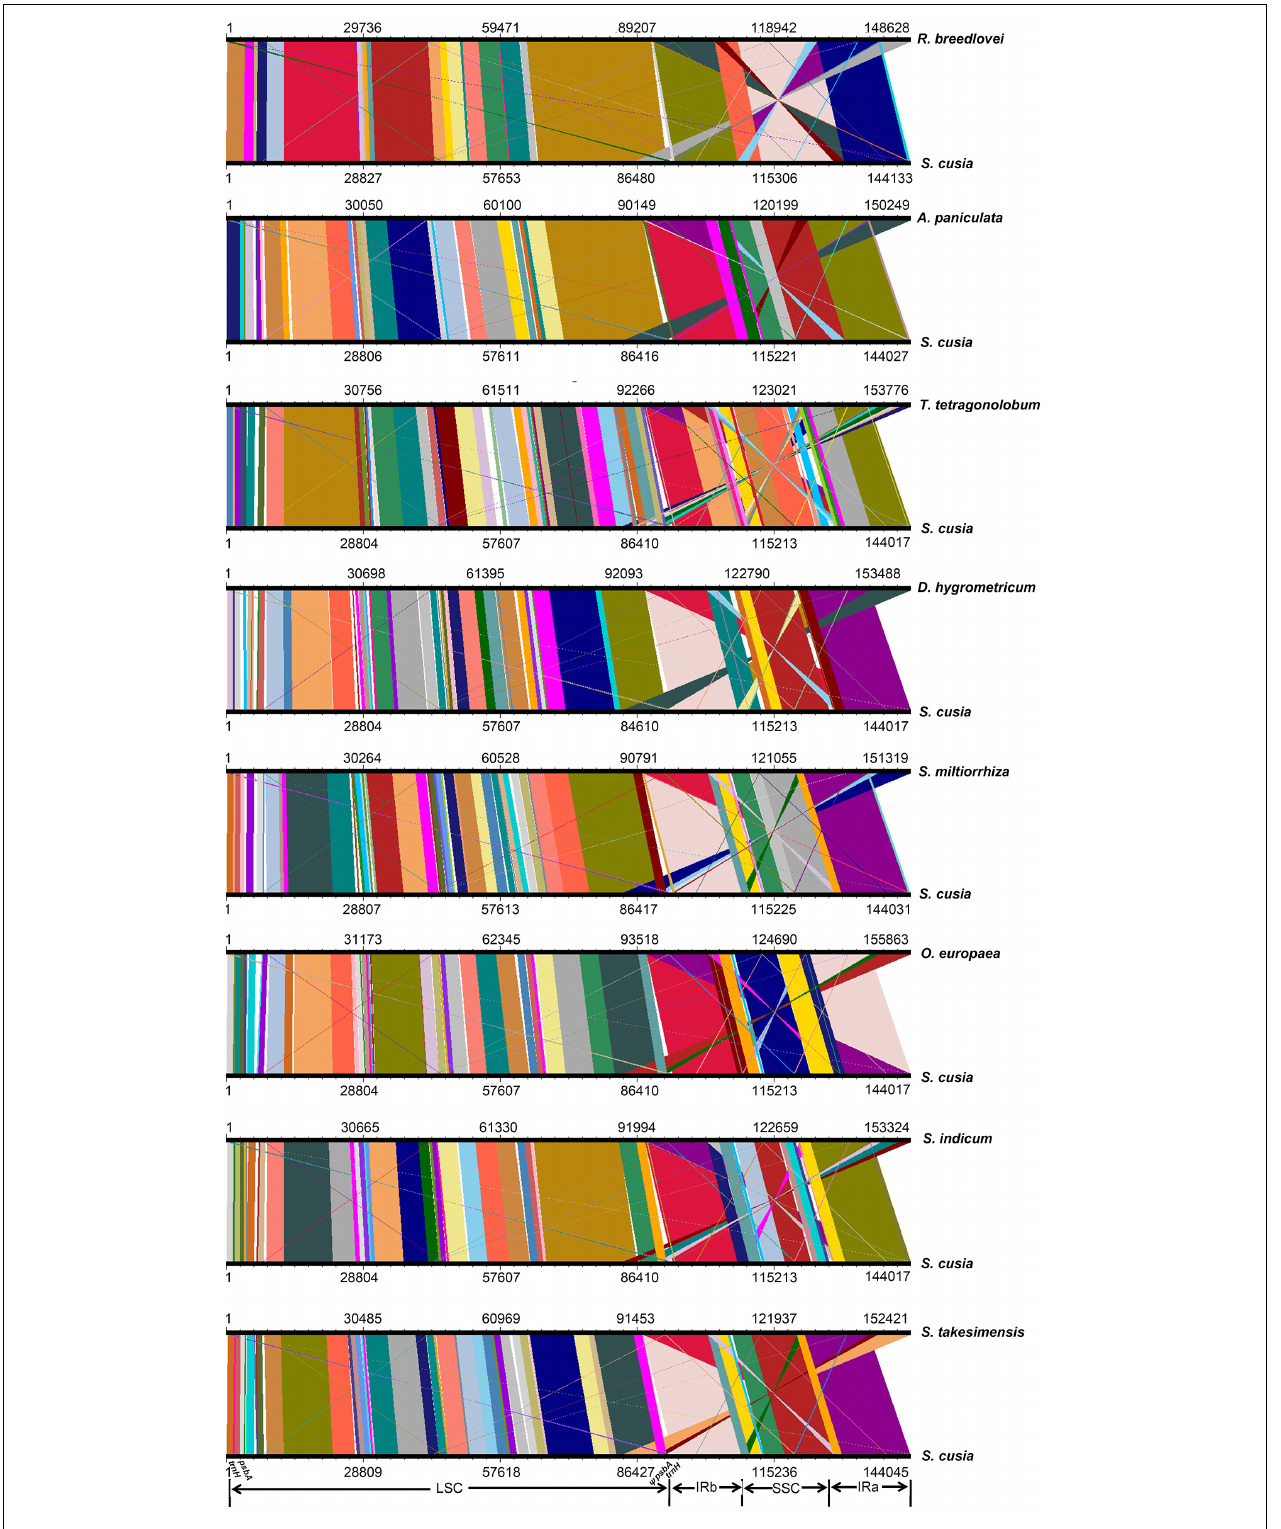
FIGURE 3 | Comparative genomic analyses of S. cusia and eight other representative species of Lamiales. The cp genome of S. cusia was aligned with those of eight species. Each horizontal black line represents one genome. The species names are shown to the right of the corresponding line. The conserved regions are bridged by